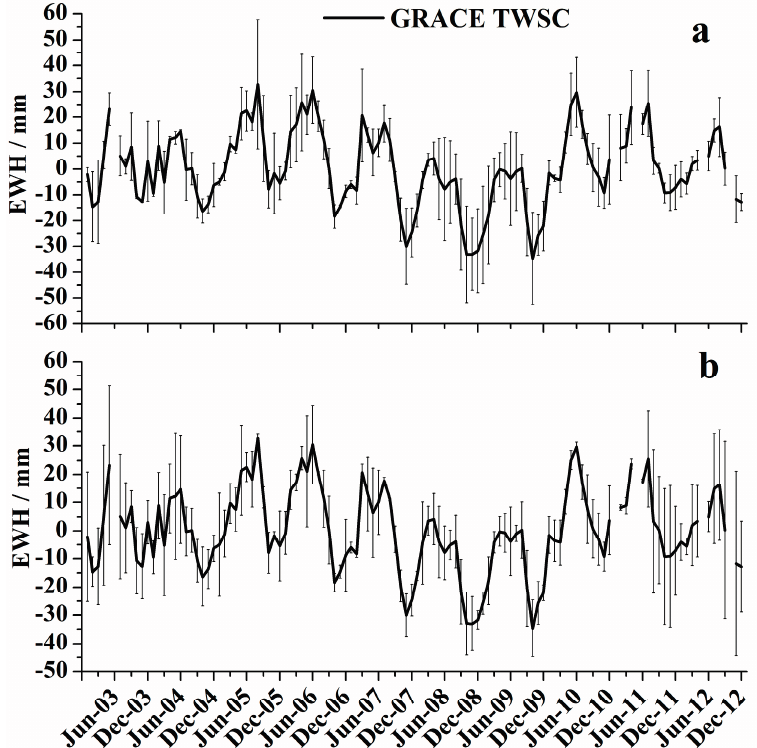
Figure 15. GRACE TWSC and their measurement errors: ( a ) Wahr’s method; and ( b ) Chen’s